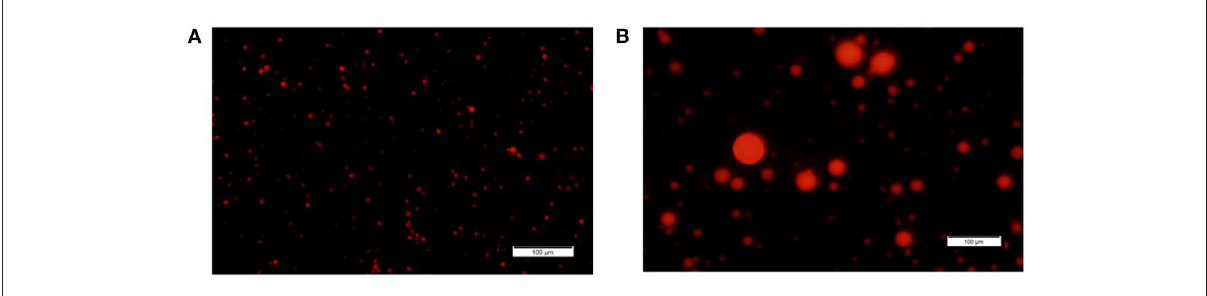
FIGURE1 MFG size fractions. Representative images of small and large MFG fractions stained with Nile red and visualized under fluorescence microscope [magnitude X20, (A, B) , respectively].